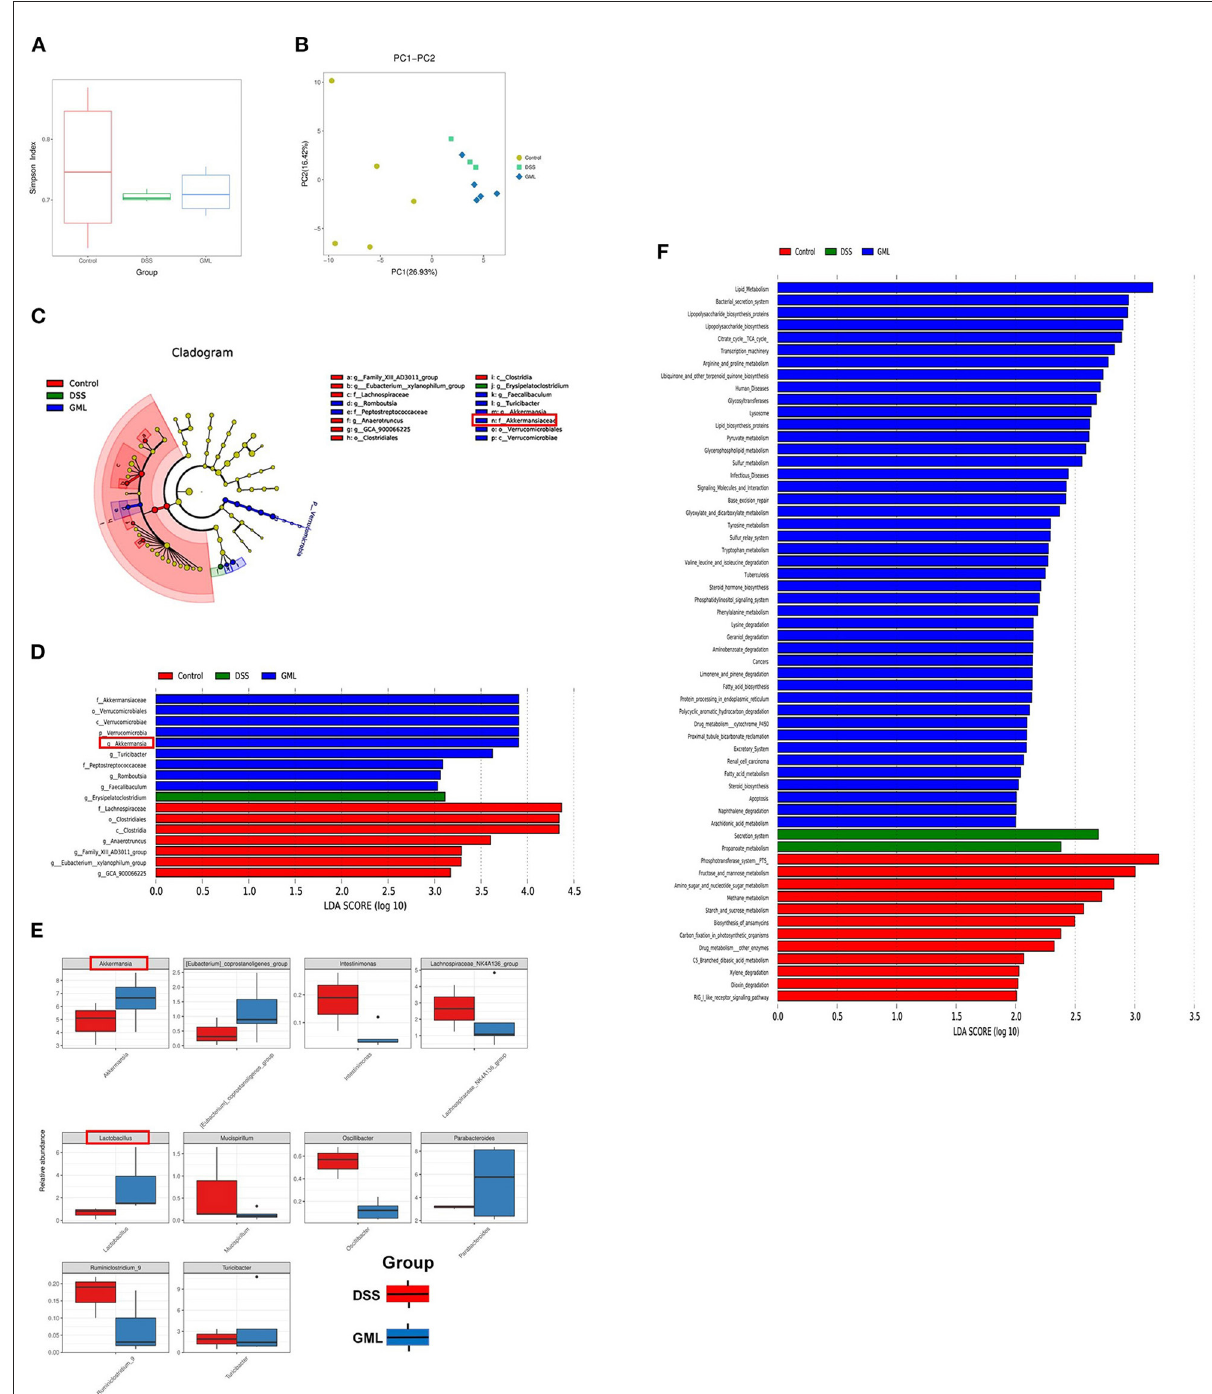
FIGURE5 GML changes the community structure of the gut microbiota ( n = 5). (A) Simpson’s index. (B) Principal coordinate analysis (PCOA) of the caecal microbiota structure measured by weighted UniFrac distances. (C) Taxonomic cladogram of LEfSe analysis results. The circle from inside to outside indicates the rank from kingdom to species, and the circle size represents the taxon abundance in the community. (D) Linear discriminant analysis (LDA) score for different taxon abundances. (E) Results of the Metastats analysis. (F) Differentially abundant pathways of the microflora at various KEGG levels. The data are expressed as the means ± SDs ( n = 5). * P <